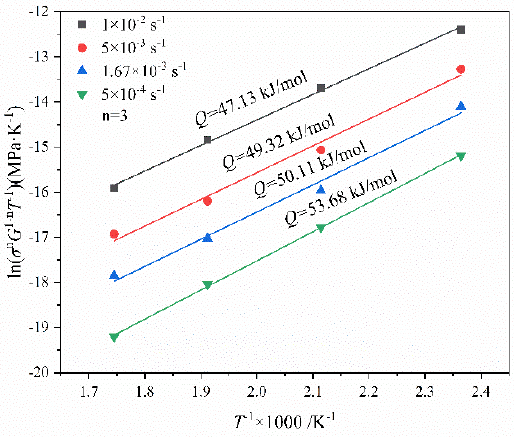
(cid:0) (cid:1) σ n G 1 − n T − 1 —1000/ T at various strain